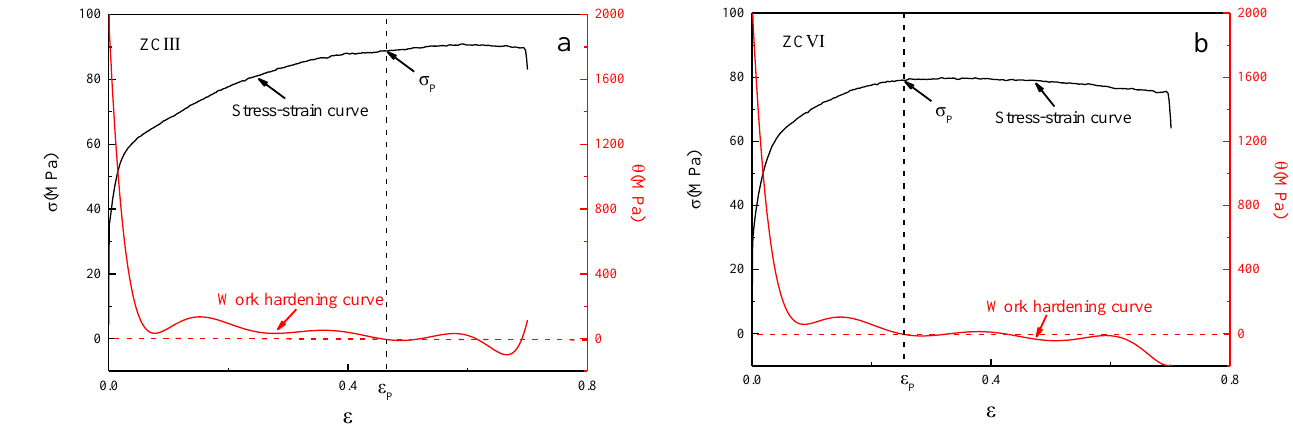
Figure 16. Typical stress – strain and θ − ε curves. ( a ) ZCIII alloy, ( b ) ZCVI alloy.